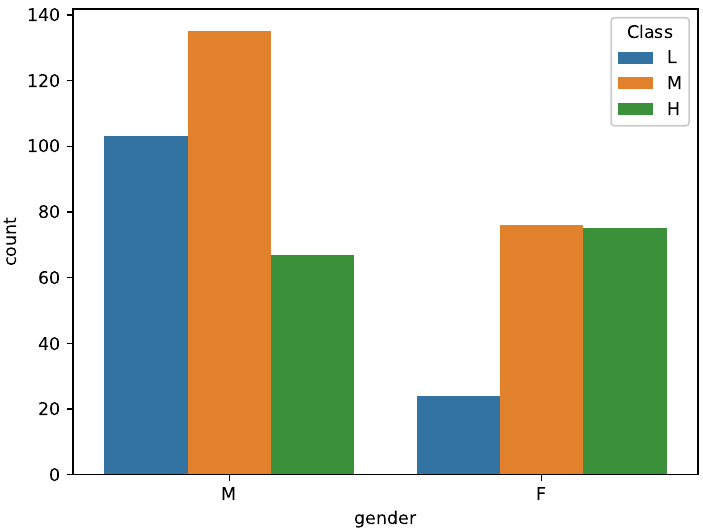
Figure 6. The relationship between student achievement and